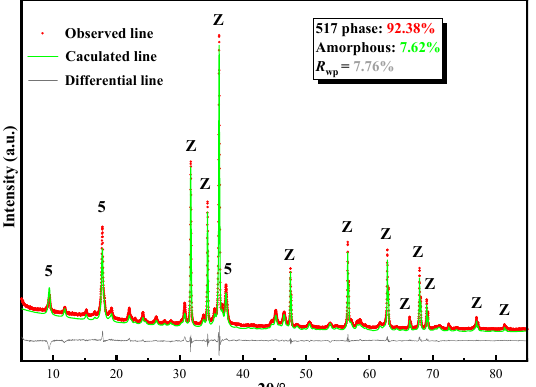
Figure 3. Quantitative Rietveld plots for synthesized hardened paste tested by external standard method: Z:ZnO, 5:517 phase.